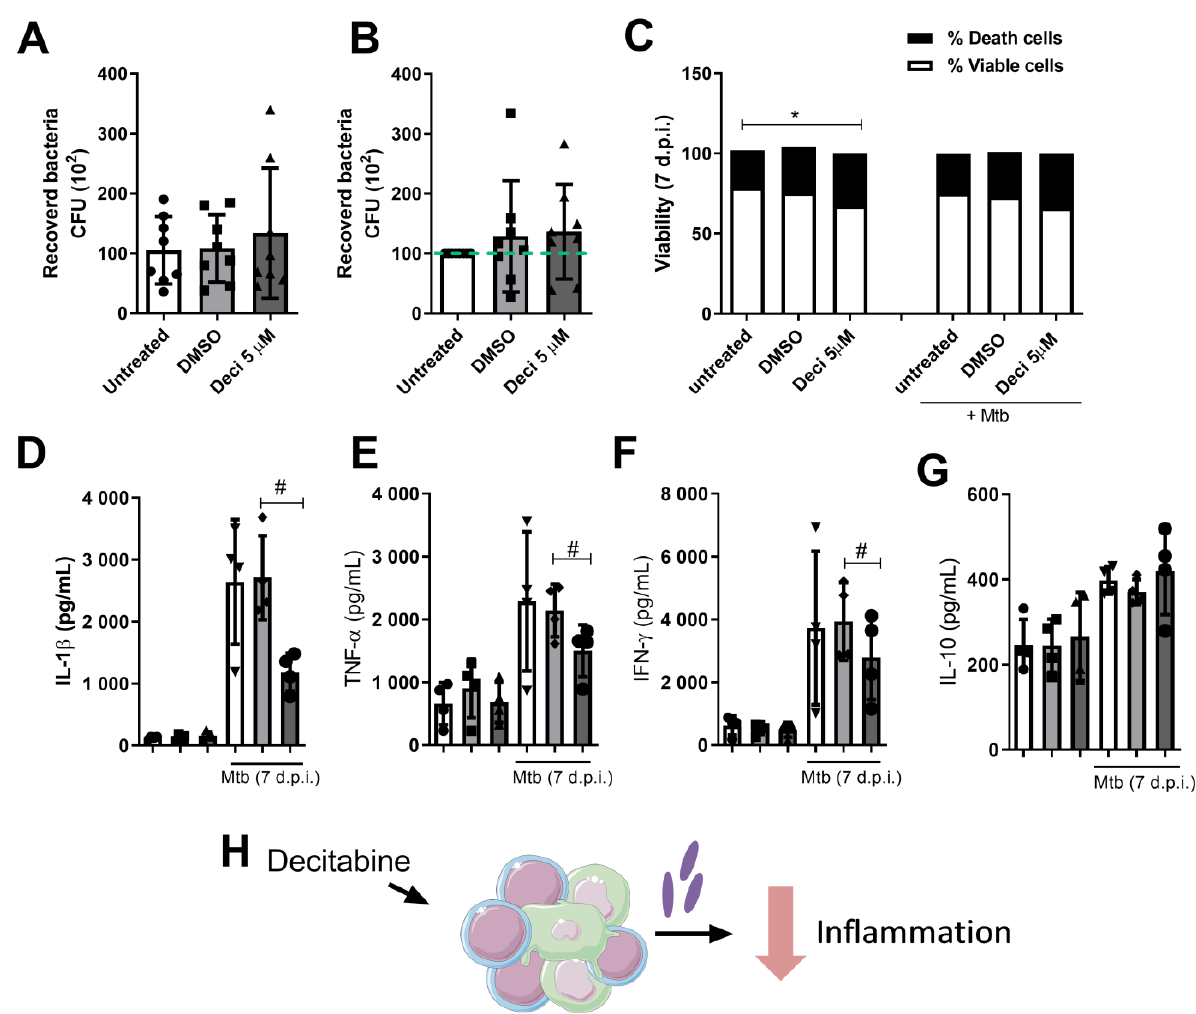
Figure 3. Decitabine reduces inflammation during Mtb infection in granuloma-like models. Peripheral blood mononuclear cells (PBMCs) were isolated and distributed (1 × 10 6 cells/well) into 48-well plates coated with an agarose layer (230 μL/well). Cells were incubated in RPMI medium supplemented with human serum (10%) for 24 h in the presence of 5